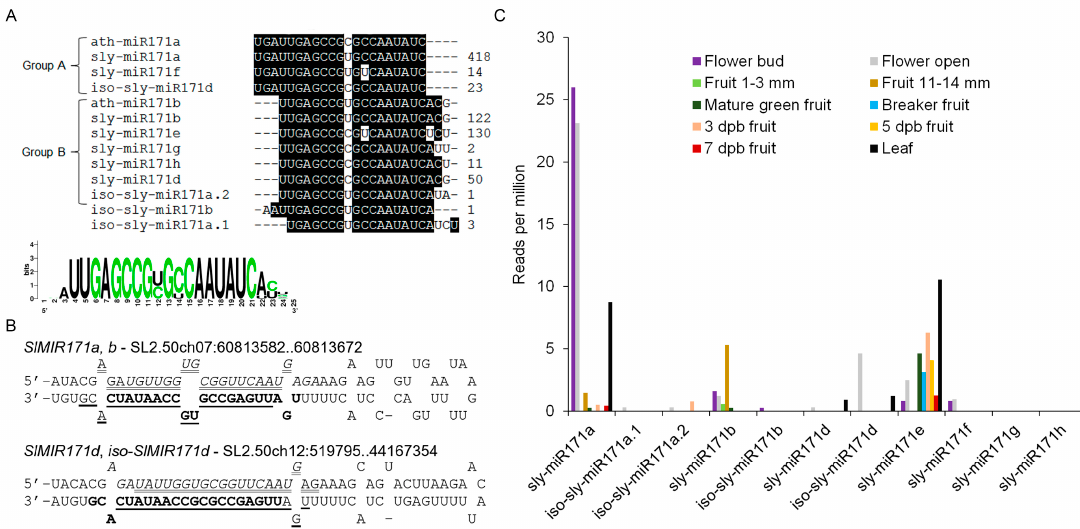
Figure 1. The tomato miR171 family. ( A ) Nucleotide sequence alignment of Arabidopsis (ath-miR171) and tomato (sly-miR171) miR171 members. Relative abundance in seedlings is indicated for each on the right. ( B ) Examples of sly-miR171 precursors that encode two sly-miR171 isoforms. The sequence of SlMIR171a,b (SL2.50ch07:60813582..60813672) and SlMIR171d , iso-SlMIR171d